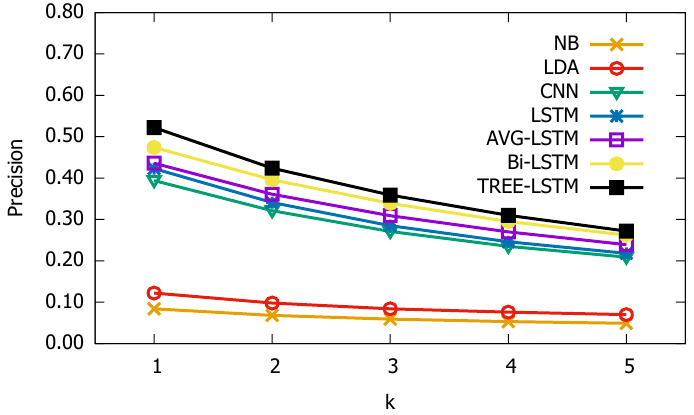
Figure 16. Precision with recommended hashtags range from 1 to 5 in Zhihu